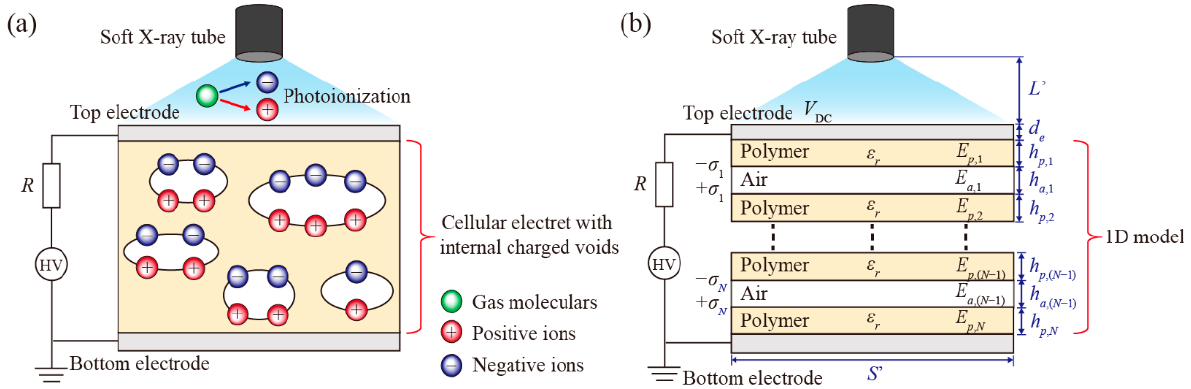
Figure 2. Soft X-ray charging cellular electrets. ( a ) Schematic of cellular electret; ( b ) One-dimensional model.